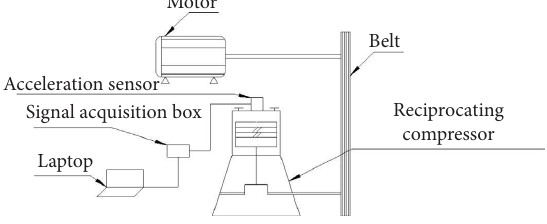
Figure 4: Te structure of the test rig.